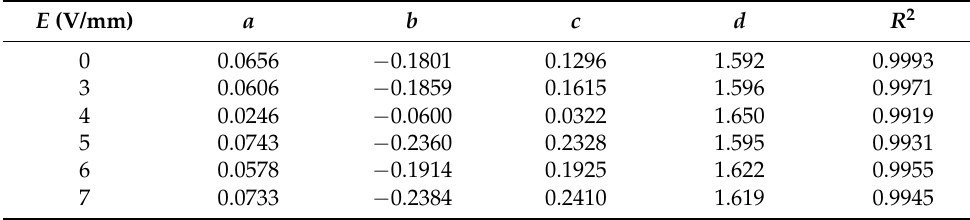
Table 1. Optimal coefficients for the cubic polynomial fit.